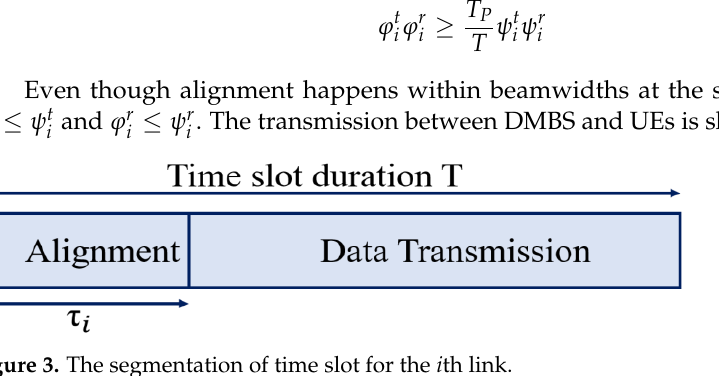
Figure 3. The segmentation of time slot for the ith link.